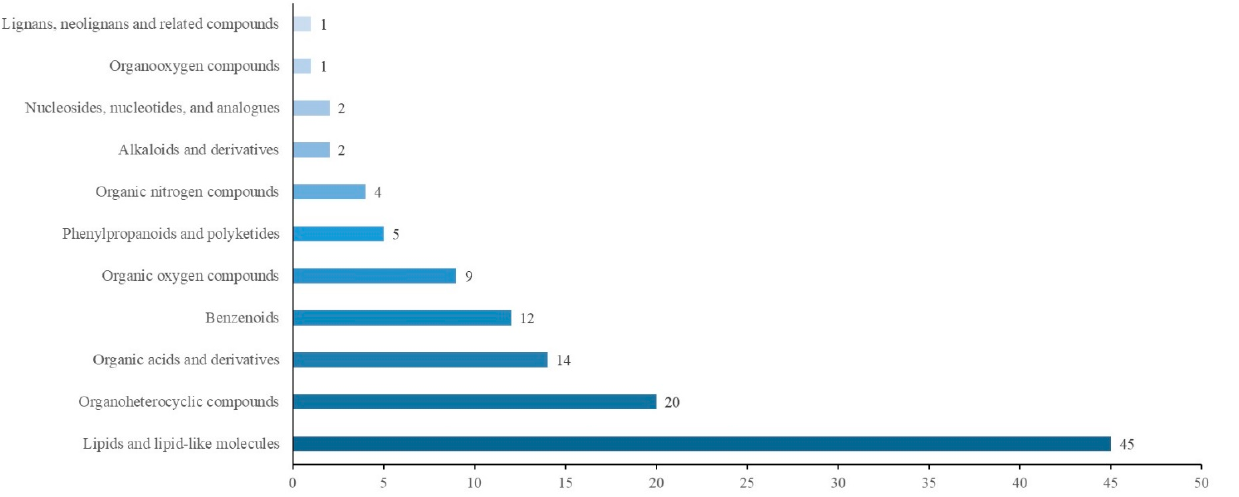
Figure 5. The HMDB annotations of differential metabolites. The abscissa is the number of differ ‐ ential metabolites involved. Figure 6. The LMSD annotations of differential metabolites. The abscissa is the number of differen ‐ tial metabolites involved.